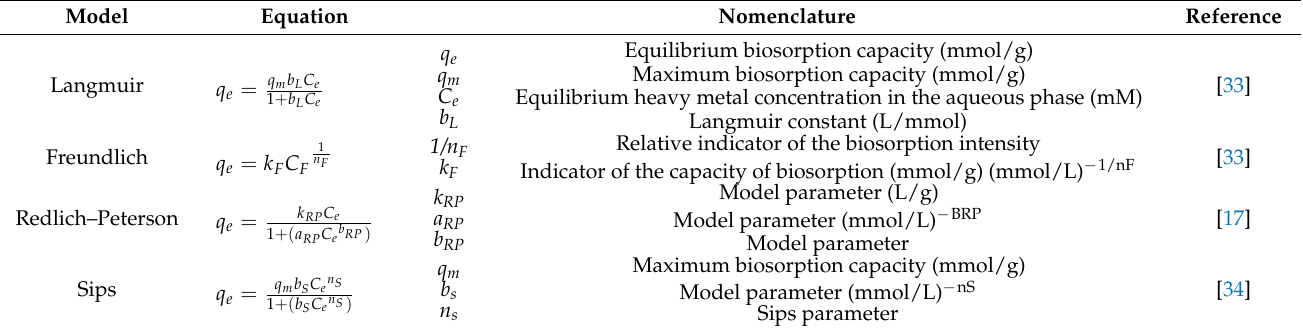
Table 1. Biosorption isotherm models for the single heavy metal